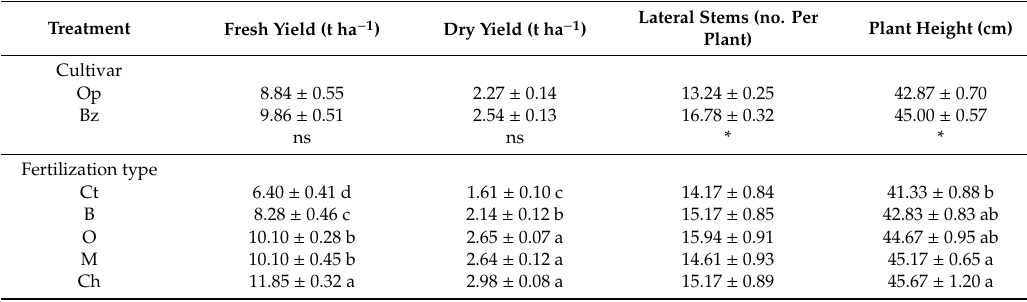
Table 2. Fresh and dry yield, and biometrical characteristics of basil as a ff ected by cultivar and fertilization.